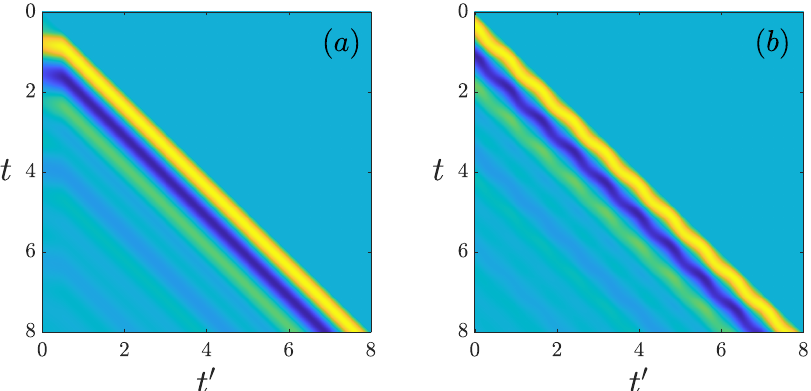
( t , t (cid:48) ) for the (a) ramp and (b) Floquet examples of the Falicov- Figure 4: Plots of G R 1 Kimball model, with propagation time T = 8. Note that the t axis has been reversed to reflect the matrix representation which we work with in the previous